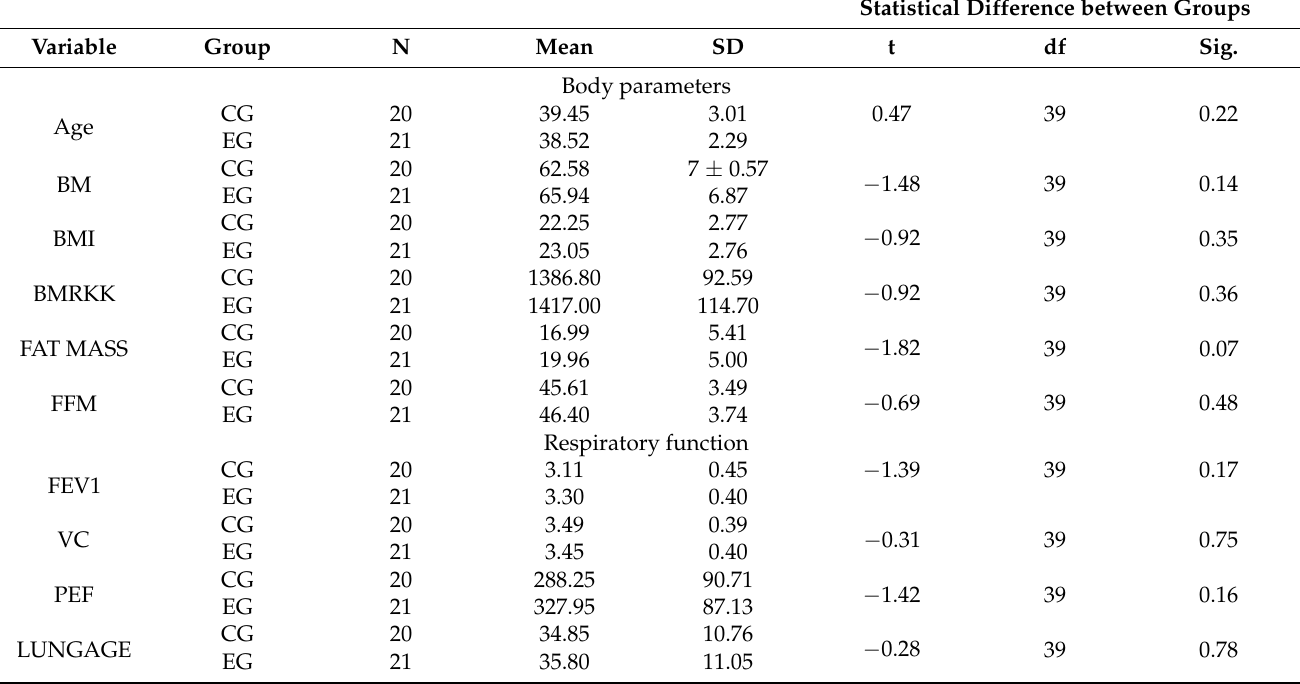
Table 1. The difference between the experimental and control groups at the initial measurement. Statistical Difference between